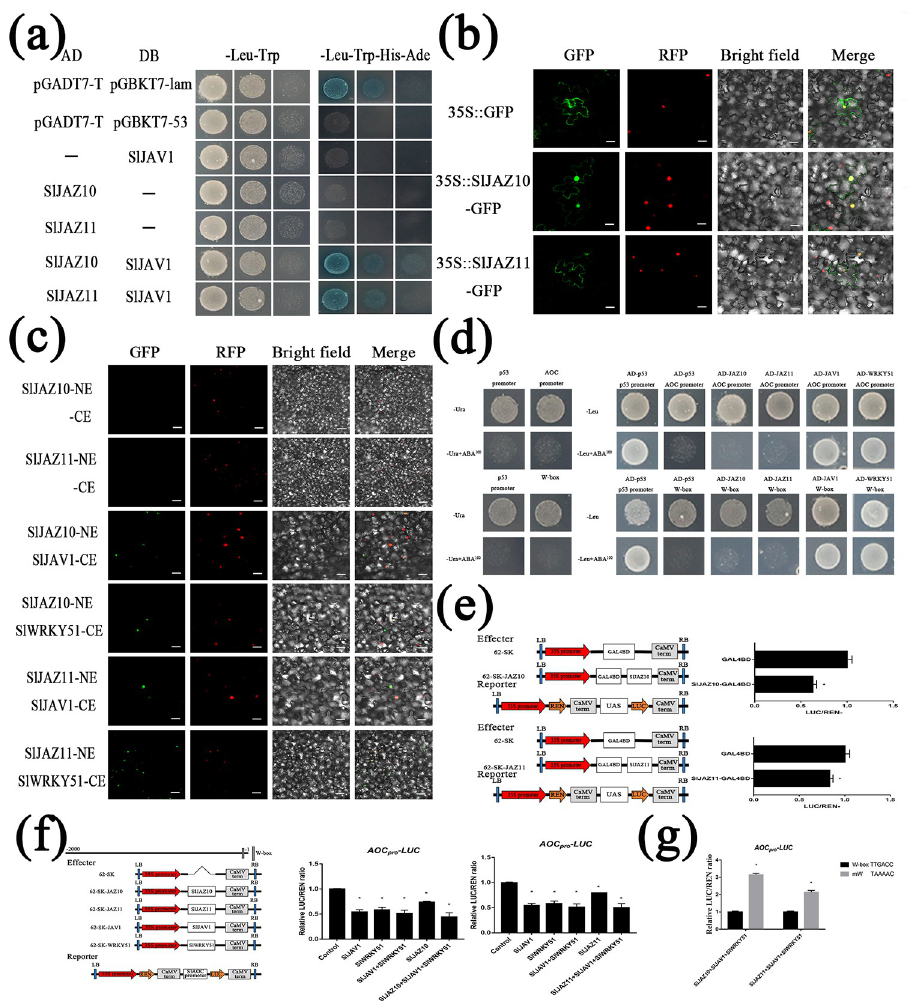
Fig 4. The JJW (SlJAZ10-SlJAV1-SlWRKY51 or SlJAZ10-SlJAV1-SlWRKY51). (a) Y2H assay shows that SlJAV1 interacts with SlJAZ10 and SlJAZ11. (b) Subcellular localization of SlJAZ10 and SlJAZ11 in the epidermal cells of N . benthamiana leaves. Bars = 40 μ m. (c) BiFC assay confirms the interactions among SlJAZ10, SlJAZ11, SlJAV1 and SlWRKY51 in N . benthamiana leaves. (d) Y1H assay shows the transcriptional binding activity of SlJAV1 and SlWRKY51 with SlAOC promoter. (e) Transient transcriptional activation assays show that SlJAZ10 and SlJAZ11 have transcriptional repression activity. (f) SlJAZ10-SlJAV1-SlWRKY51 and SlJAZ11-SlJAV1-SlWRKY51complex effectively suppresses the expression of SlAOC Pro -LUC in N . benthamiana transient expression assay. Relative ratio of LUC/REN are means ± SEM (n � 6); � p < 0. and � p < 0.05; Student’s t test. (g) Relative expression of the luciferase gene (LUC) driven by the 130bp upstream fragment of the SlAOC promoter, with the W-box intacted or